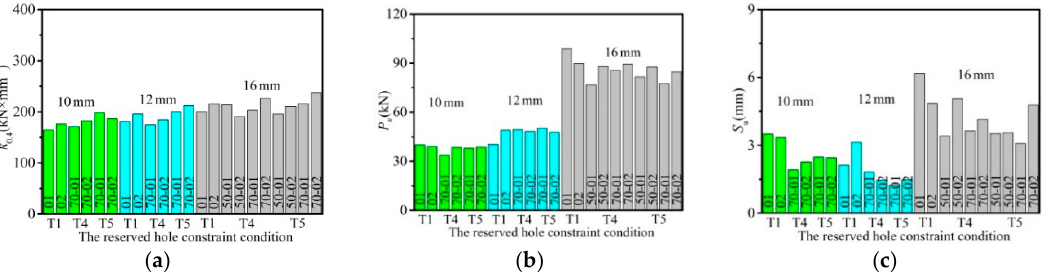
Figure 7. Effect of the reserved hole constraint condition: ( a ) shear stiffness; ( b ) shear capacity; ( c ) the maximum slip.